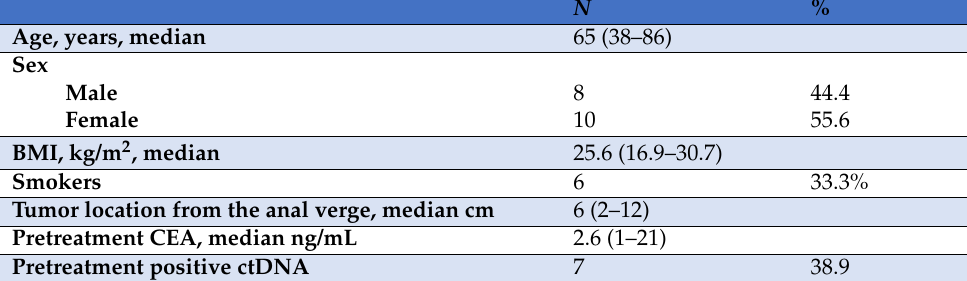
Table 1. Clinico-pathological features of the